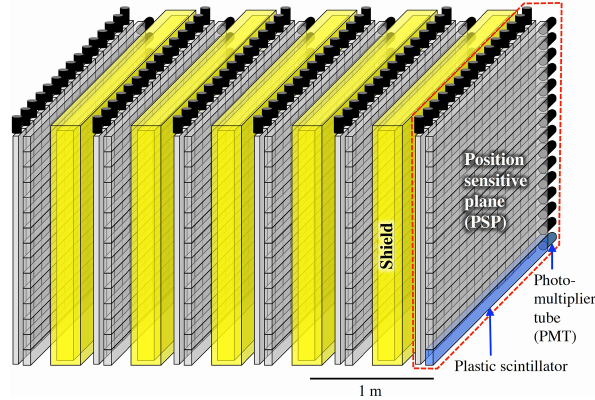
Figure 4. Schematic of the muography telescope used for the present work.